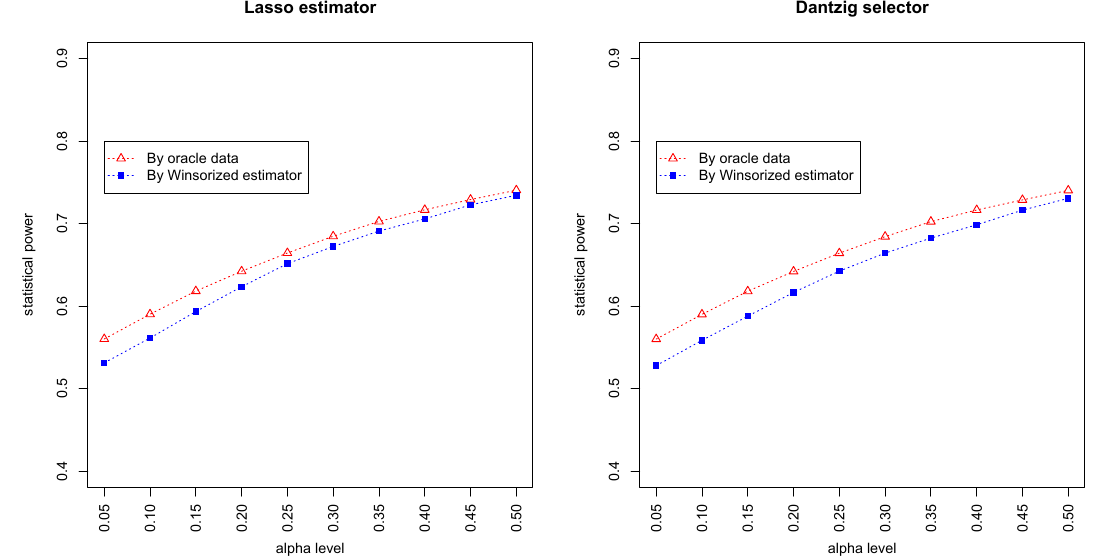
Figure 4. Statistical powers by oracle data and Winsorized estimator under the ER graph setting. The x -axis represents the desired FDR levels from 0.05 to 0.5.